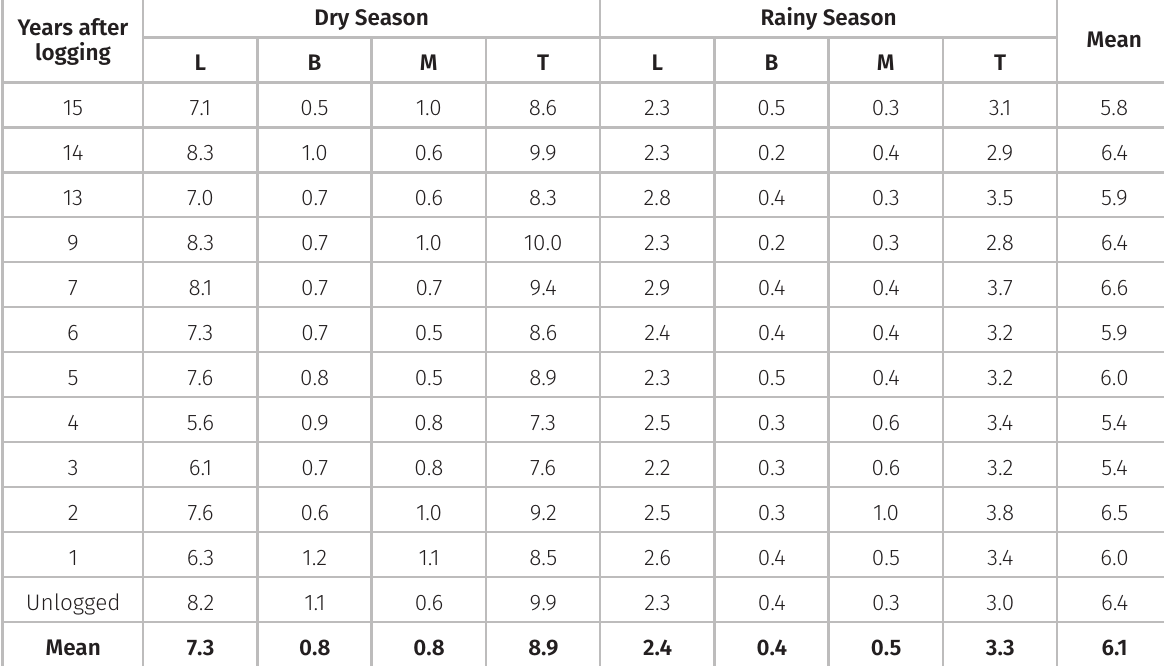
Table I. Litter deposition (Mg.ha -1 .month -1 ) by fraction – leaves (L), branches (B), and miscellaneous (M) – and total (T) in the studied sites sampled from July 2018 to October 2018 (dry season) and from January 2019 and April 2019 (rainy